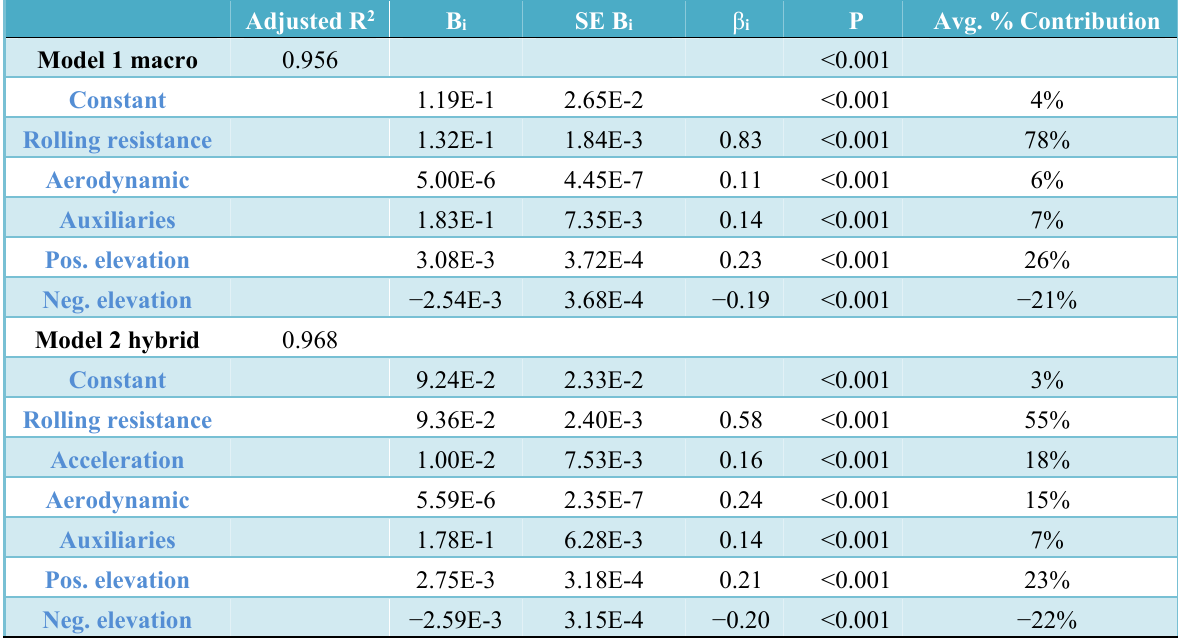
Table 1. Multiple linear regression results for the macro and hybrid